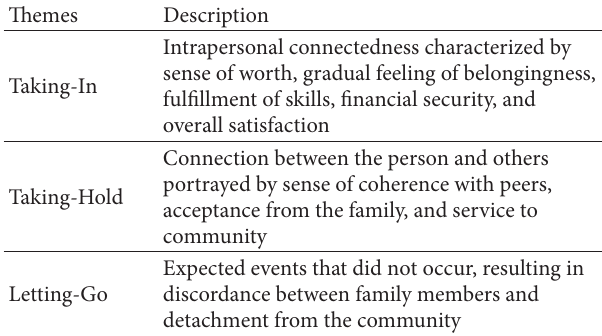
Table 4: Emerged themes and